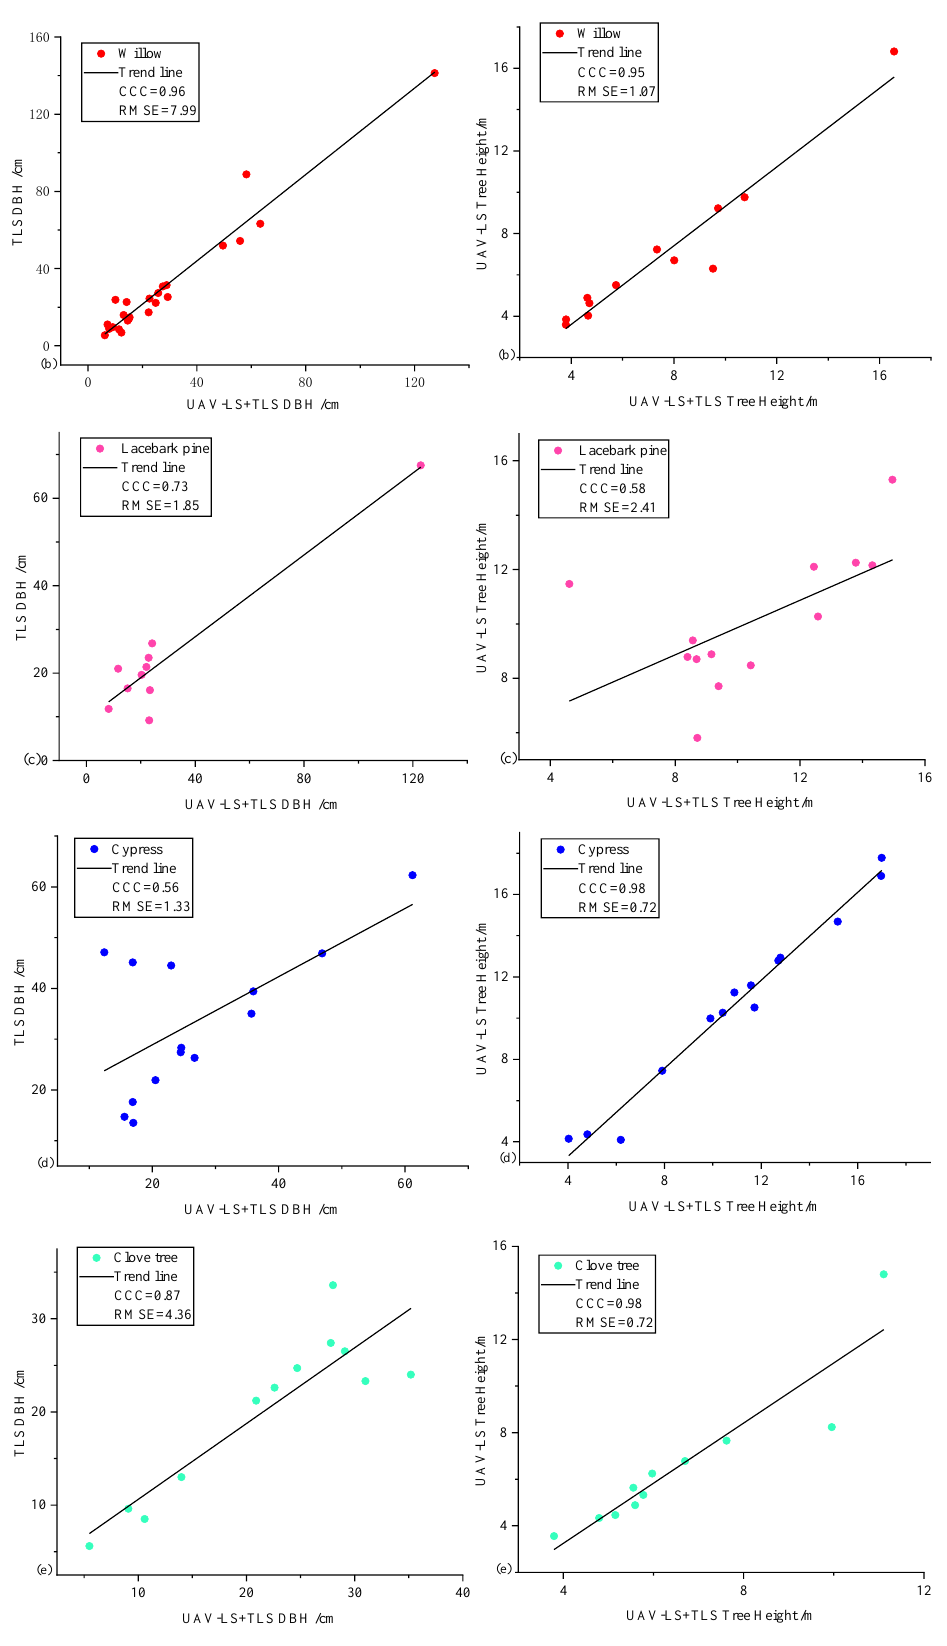
Figure 8. The DBH and tree height fit diagrams for each tree species. ( a ) Poplar, ( b ) Willow, ( c ) Lacebark pine, ( d ) Cypress and ( e ) Clove tree.